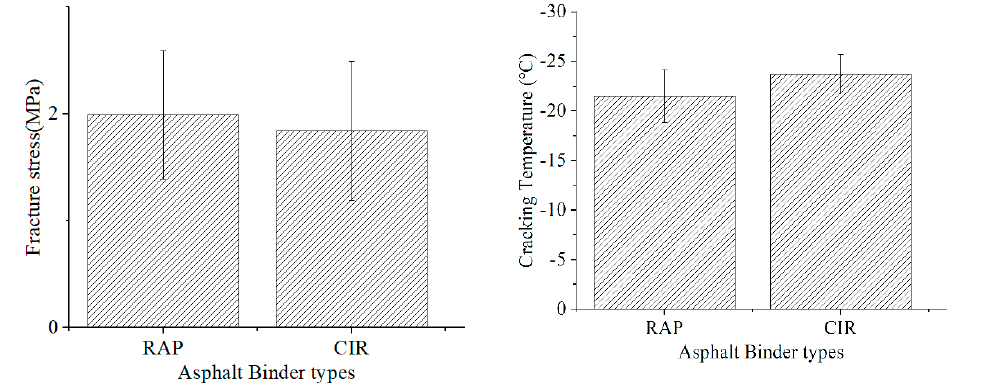
Figure 14. Asphalt cracking stress and temperature between RAP and CIR: ( a ) Cracking stress between RAP and CIR asphalt; ( b ) Cracking temperature between RAP and CIR asphalt.